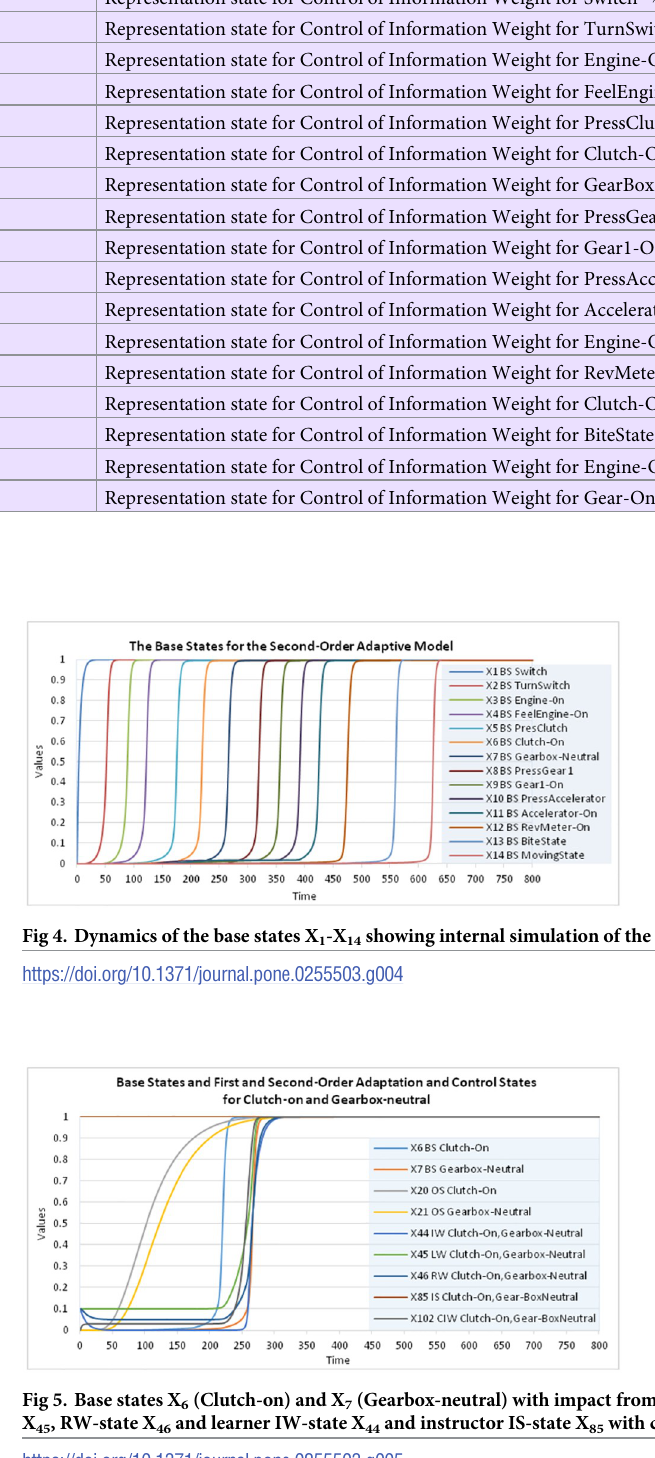
Table 6. Explanation of the second-order self-model states for control of the mental model learning in the network model. Second-order self-model states for the control of the learning